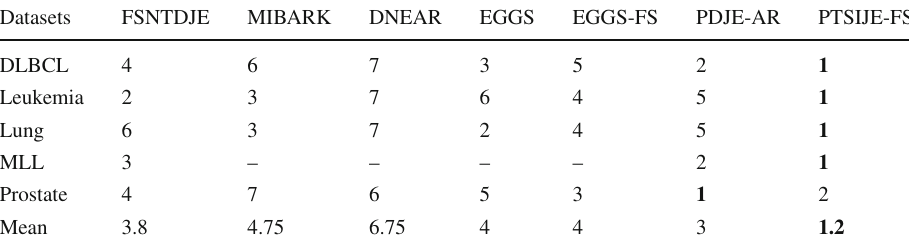
Table 14 Rank of the seven methods with